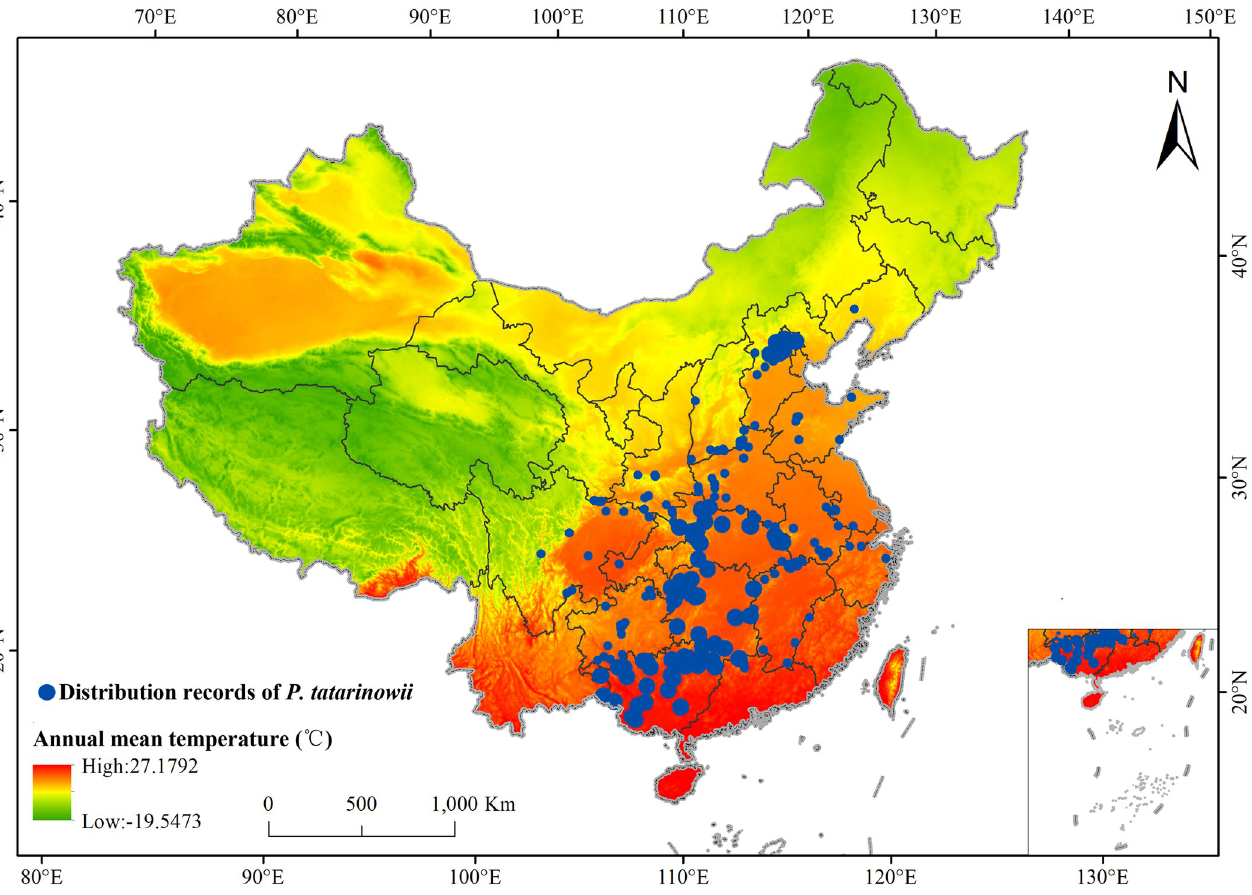
Fig 2. The distribution records of P . tatarinowi i . Larger circles indicating higher numbers of this plant, smaller circles indicating less numbers. The boundary was obtained from the Ministry of Natural Resources of the People’s Republic of China (http://bzdt.ch.mnr.gov.cn/index.html), Map review number: